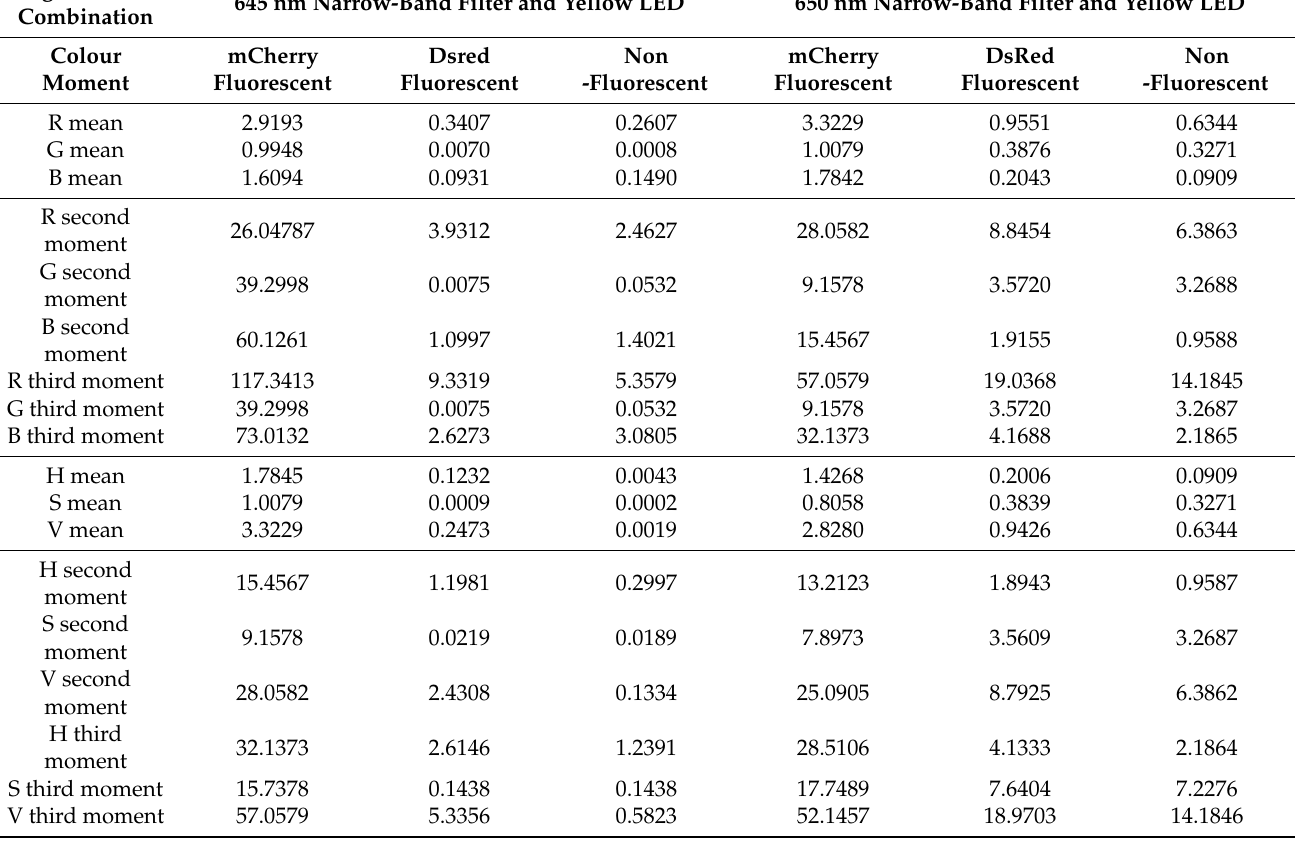
Table 3. RGB and HSV colour characteristics of the various types of maize